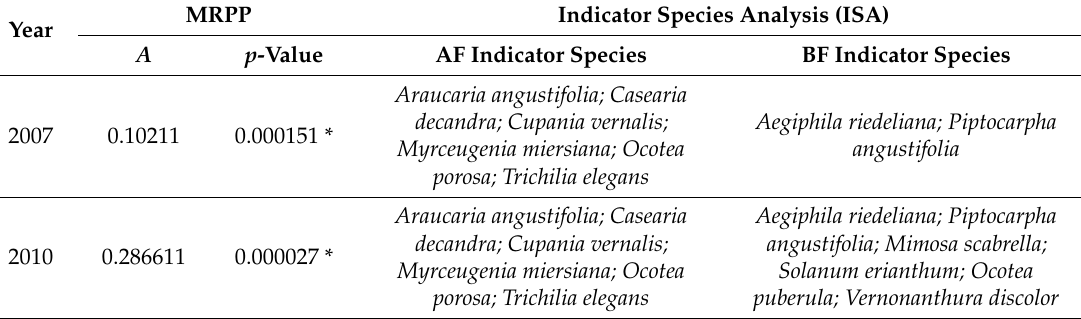
Table 3. TestofsignificanceforthedifferencesbetweengroupsusingtheMRPP(multi-responsepermutation procedures) based on species abundance and indicator species analysis (ISA). A = chance-corrected within-group agreement; measure of distance based on Sorensen